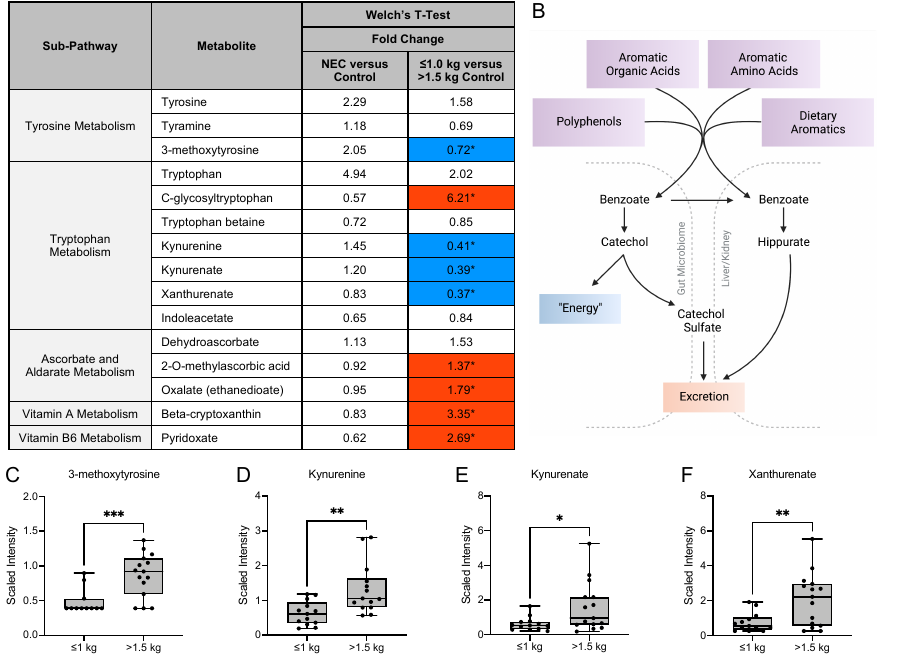
Figure 6. Tyrosine, tryptophan and vitamin metabolites in maternal milk vary among birth weight control groups. ( A ) Fold change concentration of tyrosine, tryptophan and vitamin metabolites in maternal milk. Red cells indicate mean values that are significantly higher and blue cells indicate mean values that are significantly lower for the designated comparison. ( B ) Microbial action within the intestine facilitates the metabolism of aromatic amino acids and vitamins. Figure created with BioRender.com. ( C – F ) Boxplots of concentration levels of 3-methoxytyrosine, kynurenine, kynurenate and xanthurenate between the birth weight control groups. * p ≤ 0.05, ** p < 0.01, *** p < 0.001 by Welch’s T-Test.